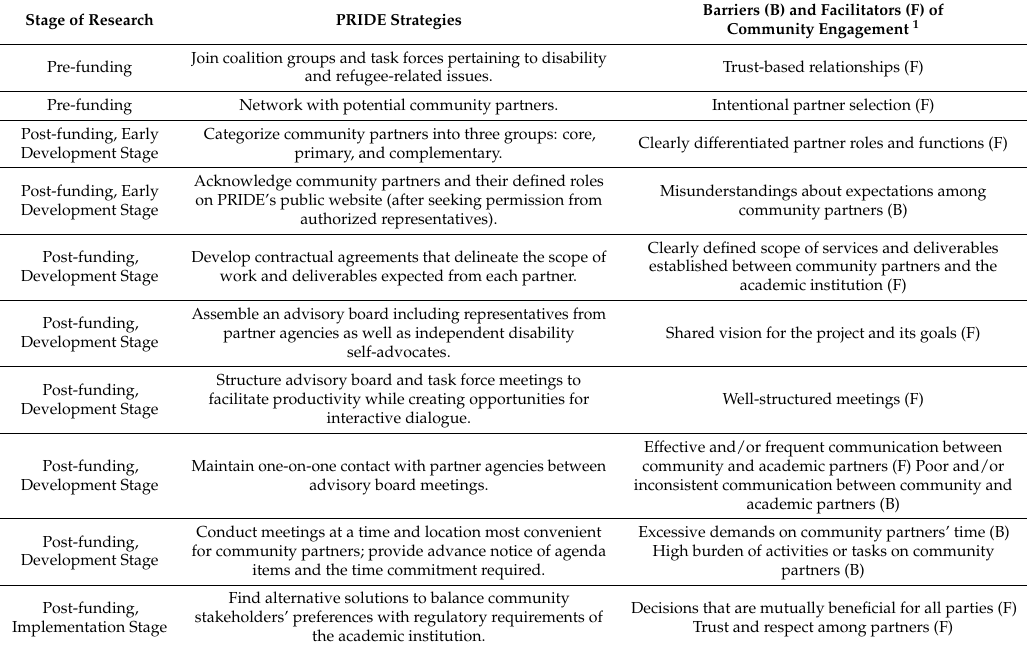
Table 1. Community engagement strategies, barriers, and